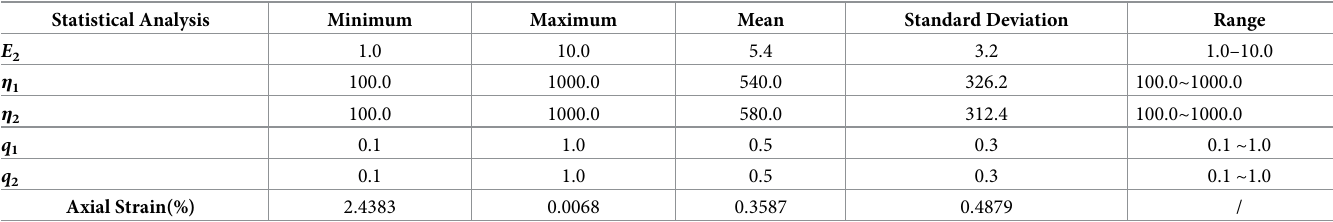
Table 5. Statistical analysis of test